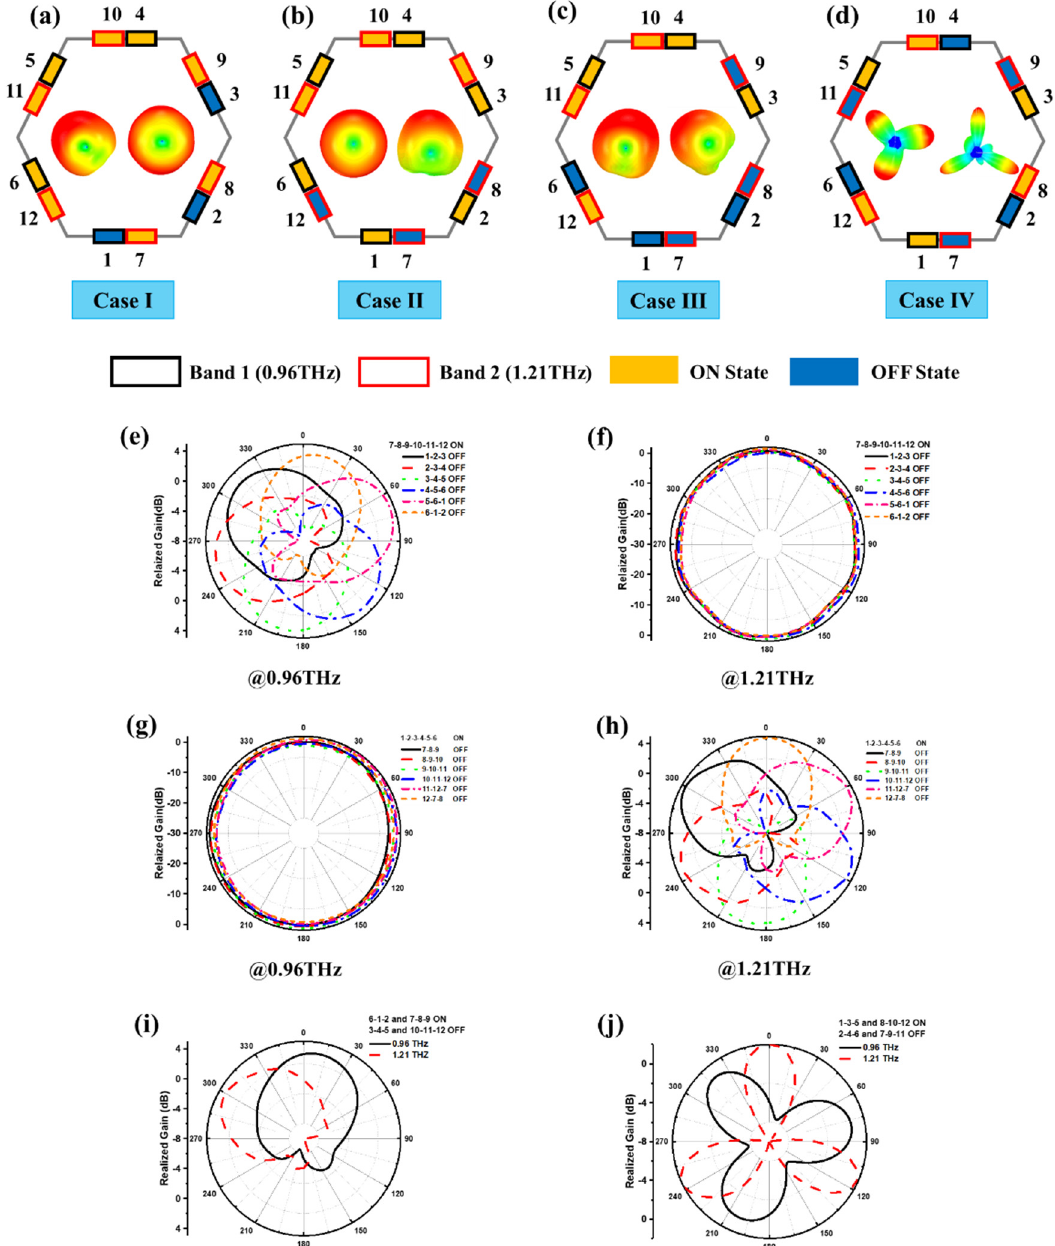
Fig. 5. Topologies of the beam steering antenna under different ON/OFF states. (a) Case I, (b) Case II, (c) Case III and (d) Case IV. Radiation patterns in the azimuth plane of (be Case I at 0.96 THz, (f) Case I at 1.21 THz, (g) Case II at 1.21 THz, (h) Case II at 0.96 THz, (i) Case III at two frequencies, and (j) Case IV at two